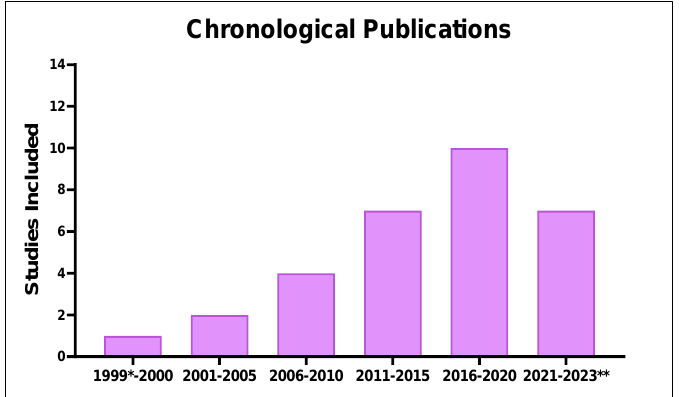
Figure 2. Distribution of published studies on inspiratory muscle warm-up applied to athletes and healthy and active individuals (period analyzed: 1999 to 2023). * First publication. ** Reviewed until 17 January 2023.